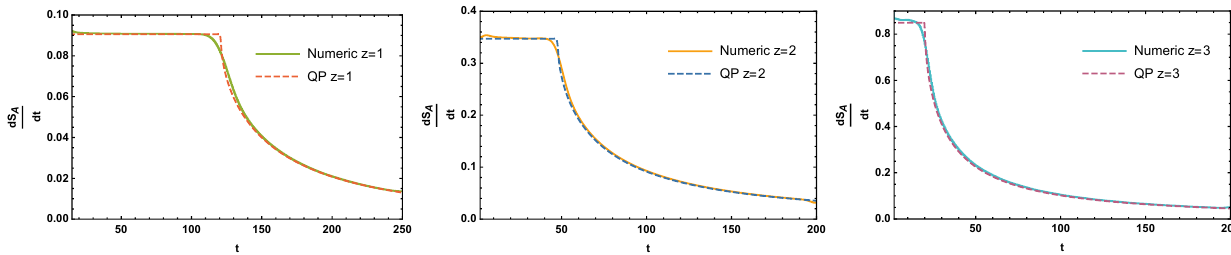
Figure 7 . Numerical versus analytic results for time evolution of EE for z = 1 ; 2 ; 3. Here we set m 0 = 1 and m = 2. There is a very good matching between quasi-particle analytic results and numerics. The small di(cid:11)erence at the early times is due to numerical instability and the mild transition in numerical results is due to the zero mode which is not captured by the quasi-particle picture. In these plots we have set the subregion size to be 100 in units of lattice